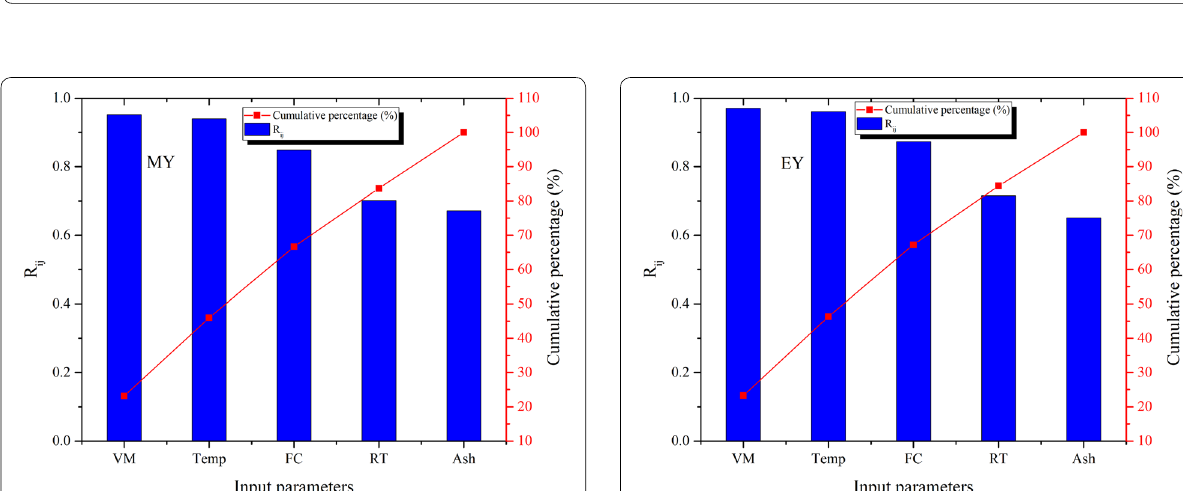
Fig. 10 Model comparison for the HHV using a testing datasets, b validation datasets